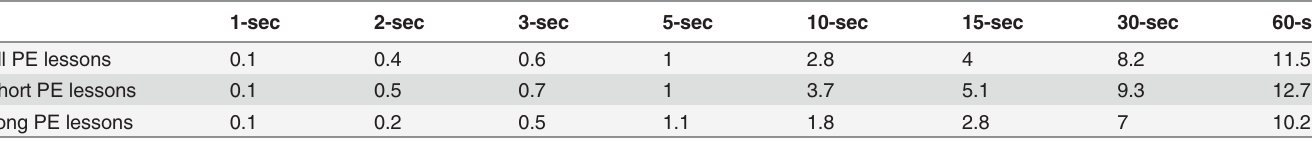
Table 1. Percentages of compliance with guidelines (50% of wear time in MVPA) for PE lessons.